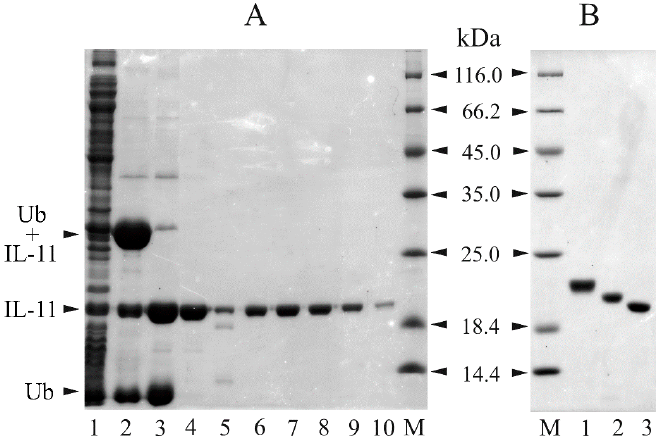
data for macaque IL-11 are similar), controlled by reducing SDS-PAGE (15%; staining by Coomassie brilliant blue R-250). Lane 1, soluble extract of the cells expressing the Ub-IL-11 fusion; lanes 2 and 3, the affinity-purified Ub-IL-11 fusion sample before and after the cleavage by Usp2 protease, respectively; lane 4, the IL-11 sample after cleaning from ubiquitin and Usp2 protease; lanes 5–10, the protein fractions after the gel filtration using Sephacryl S-100 HR medium (the sample shown in lane 5 was discarded). ‘M’ denotes the lanes with molecular mass standards (the masses in kDa are indicated in-between the panels A and B ); ( B ) SDS-PAGE of the purified recombinant human, macaque and murine IL-11 (lanes 1, 2 and 3, respectively).